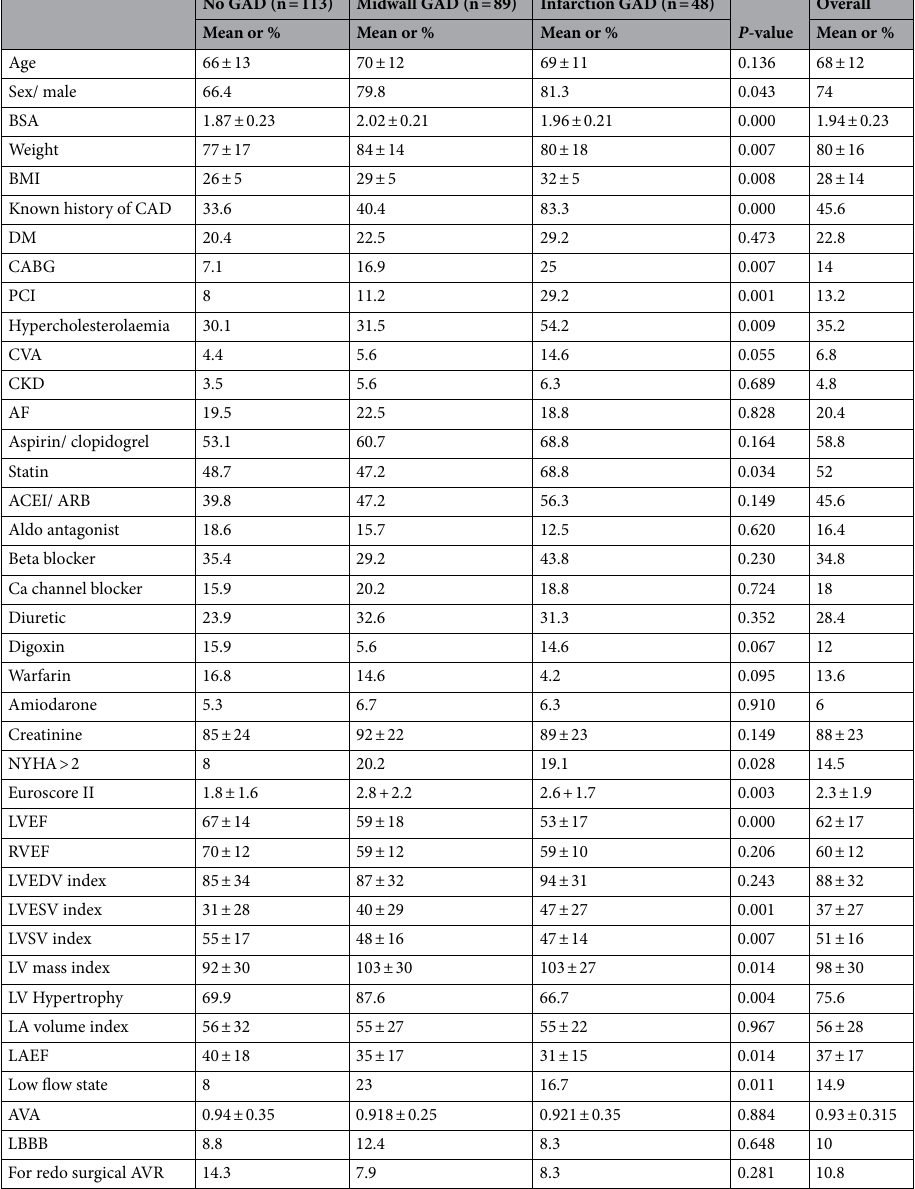
Table 1. Baseline characteristics of patients according to presence or absence of late gadolinium enhancement on